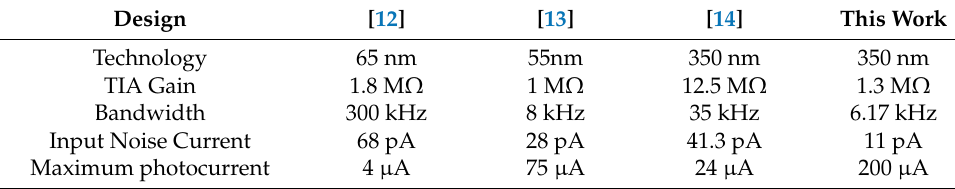
Table 5. Comparison with recently published research for PPG-based